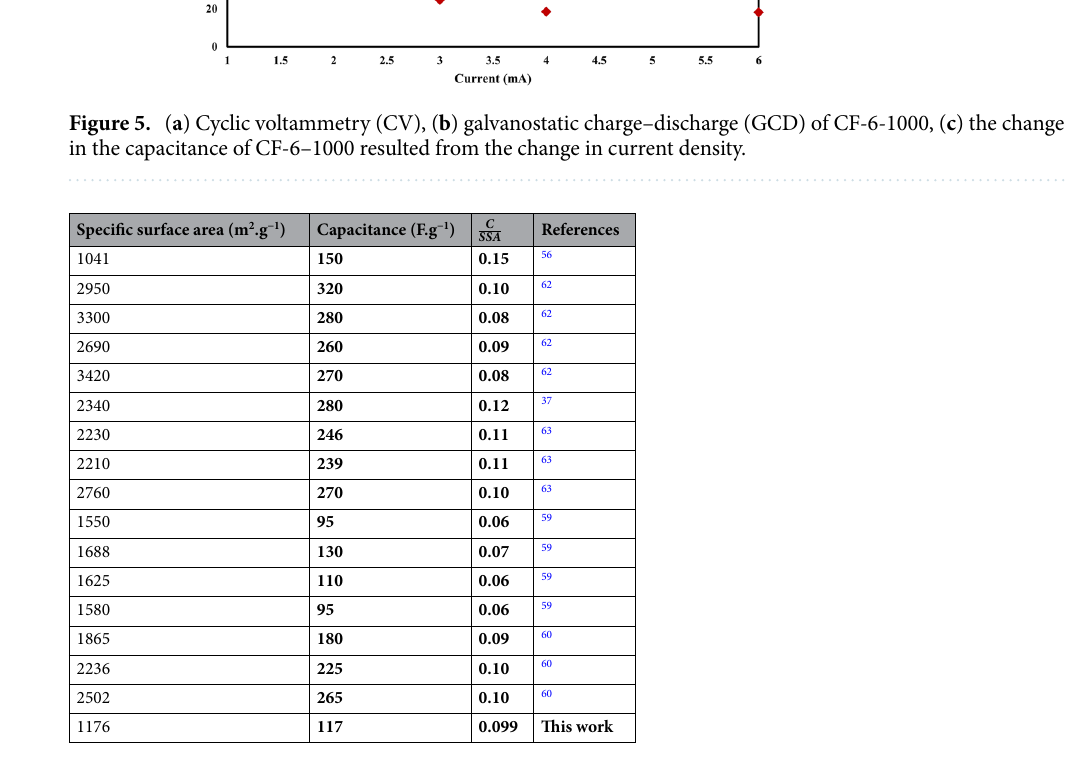
Table 2. Competition of the obtained capacitance from some activated carbons. C capacitance, SSA specific surface area.